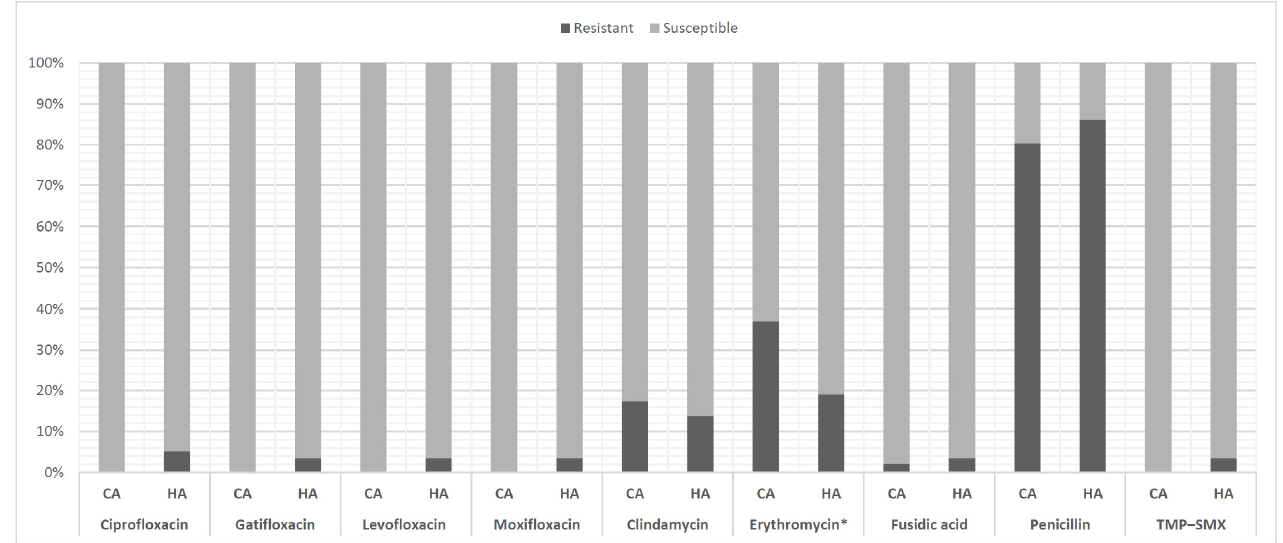
Figure 3. Antibiotic susceptibility of community-associated and health-care-associated methicillin-susceptible Staphylococcus aureus ocular isolates. CA = community-associated; HA = health-care-associated; TMP–SMX = sulfamethoxazole–trimethoprim; * p = 0.047.